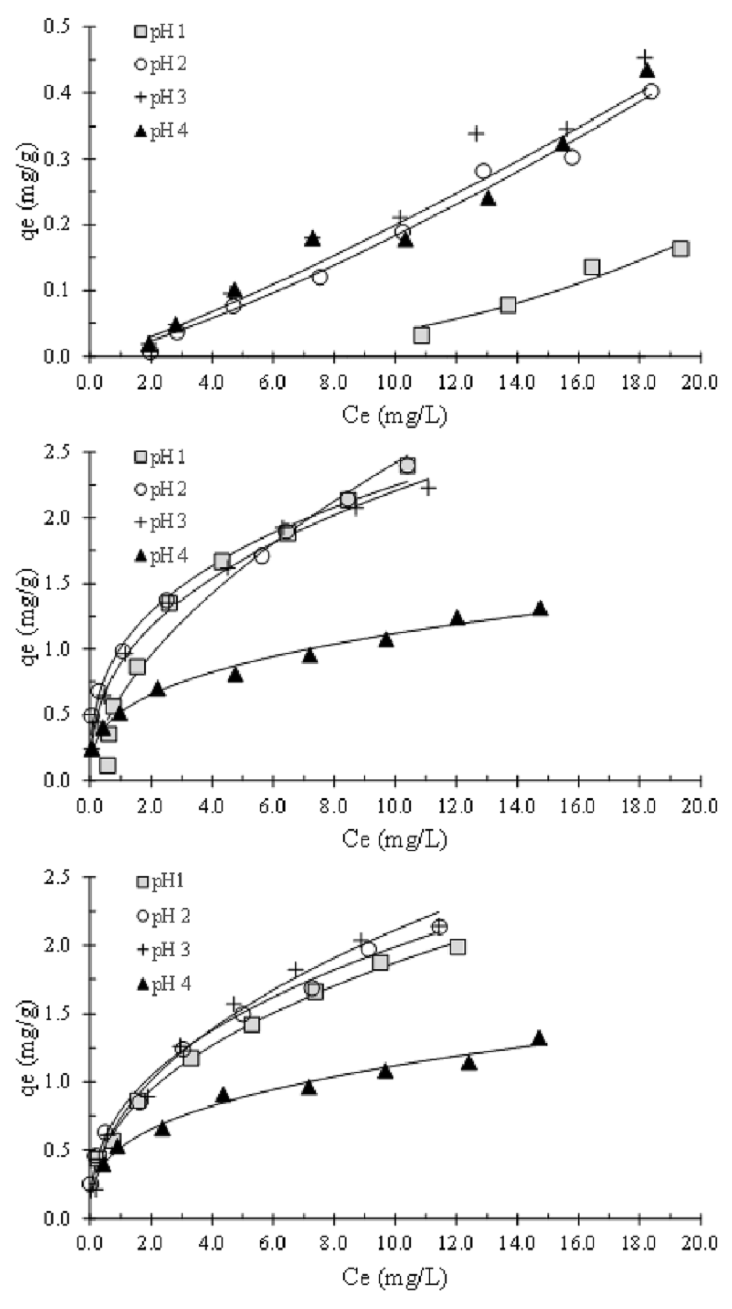
Figure 4. Adsorption isotherms adjusted by Freundlich model for (a) CBC, (b) 0.5FeBC and (c) 1.0FeBC sample in pH 1 to 4.